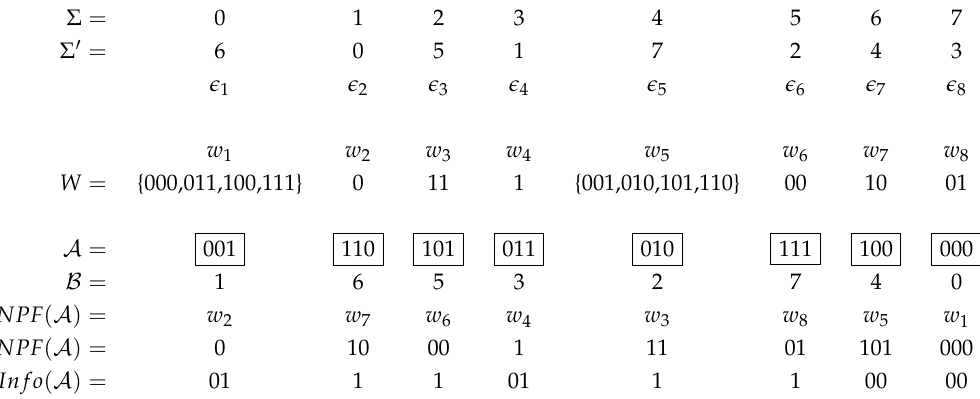
Figure 1. A simple sketch of the non-prefix-free coding of an input bit sequence A , where B is the representation of A with the block length d = 3. Σ (cid:48) is a random permutation of the corresponding alphabet Σ , and W is the non-prefix-free code-word set generated for Σ (cid:48) according to Definition 2. The disambiguation information DisInfo ( A ) is computed according to Lemma